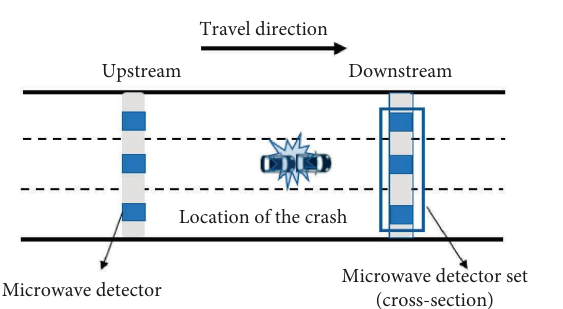
Figure 1: Location of trafc information detectors in relation to the location of trafc